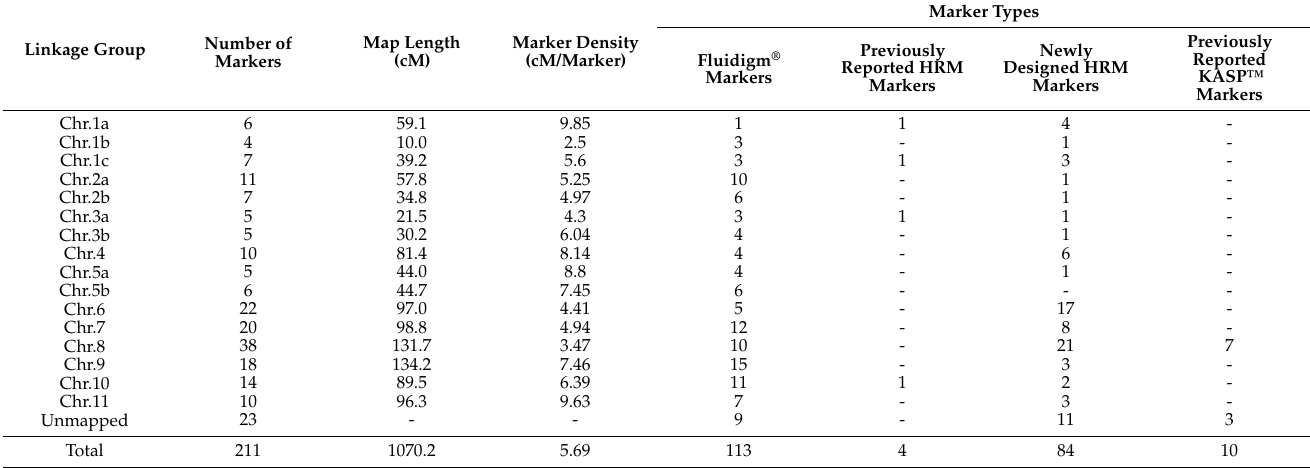
Table 1. Summary of the distribution of single nucleotide polymorphism (SNP) markers in watermelon genetic map.